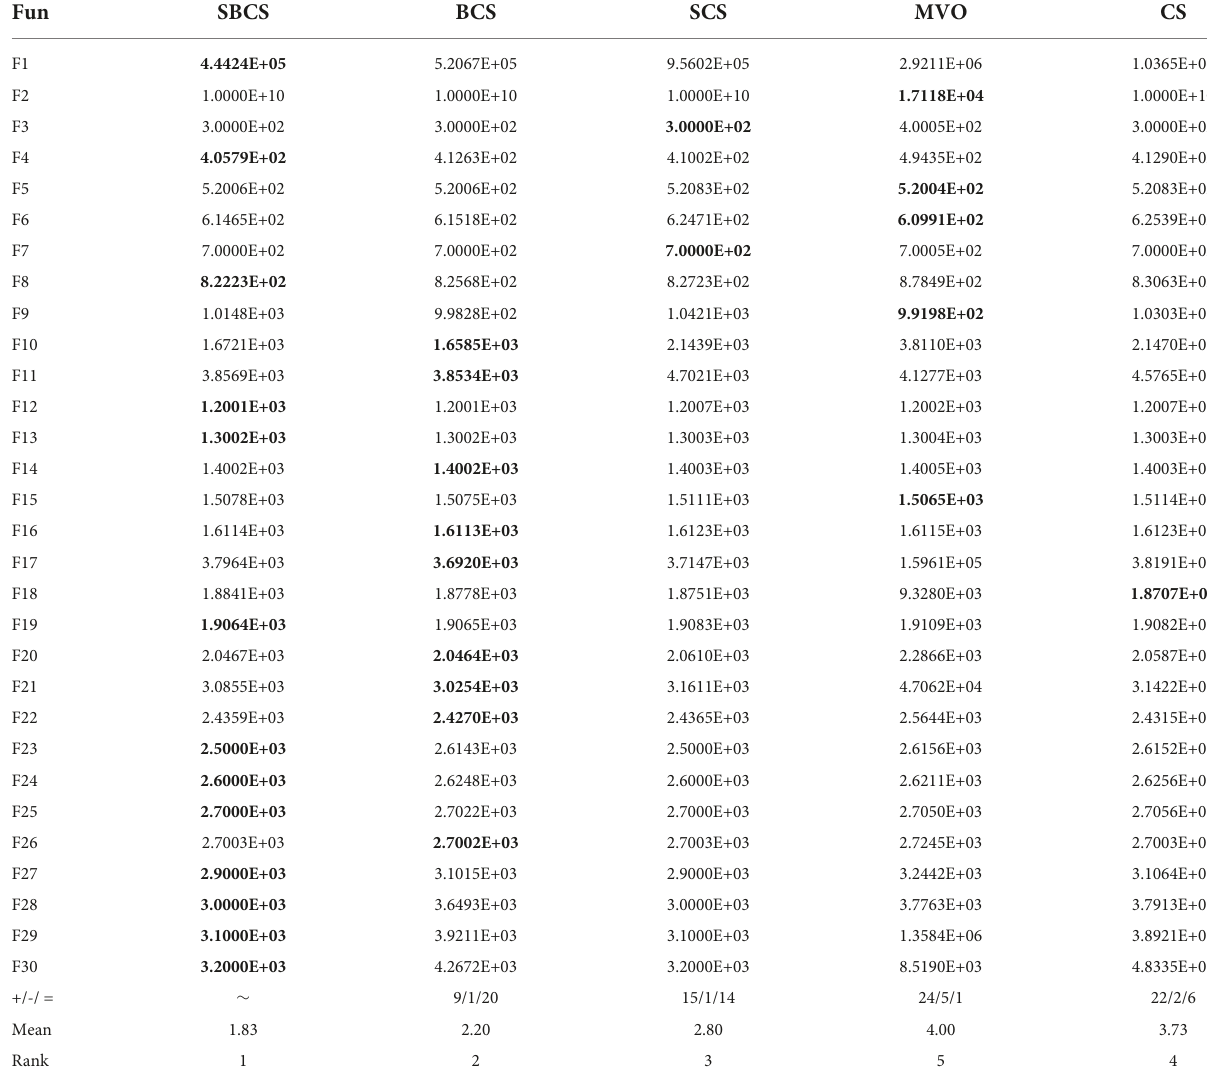
TABLE 6 Average fitness values of ablation experiments and Wilcoxon